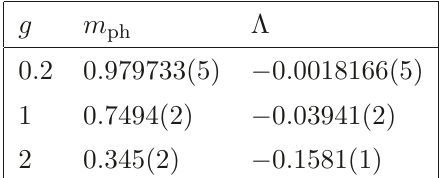
Figure 3 . m ph ( g ); compare with figure 11 in [18].